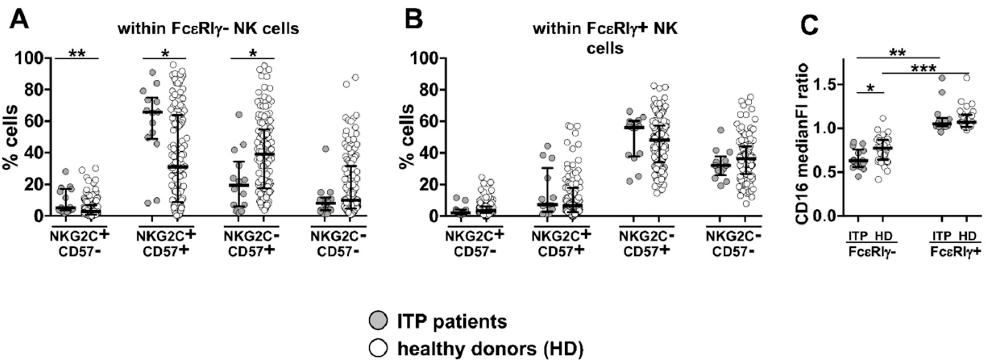
Figure 4. Altered memory NK subset profile in ITP patients. Percentage of Fc ε RI γ − ( A ) and Fc ε RI γ + ( B ) CD16 + CD56 dim NK cell subsets in a cohort of 14 ITP patients (grey) and 121 HCMV + healthy individuals (empty), both under 65 years of age, and with a sizeable Fc ε RI γ − memory pool (>5% of total NK cells). Bars represent median with interquartile range. p values of pairwise comparisons were calculated by Mann–Whitney non-parametric test and reported when significant (<0.05): (*) p = 0.01, (**) p < 0.005. ( C ) CD16 surface levels were evaluated in 14 ITP patients (grey) and 31 age- and sex-matched HCMV + healthy individuals (empty) and expressed as median fluorescence intensity (medianFI) ratio of Fc ε RI γ − or Fc ε RI γ + populations vs. medianFI of CD56 dim NK cells. Bars represent median with interquartile range. p values of pairwise comparisons were calculated by